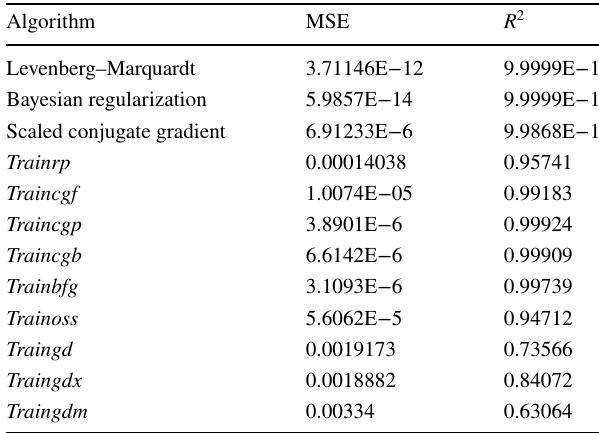
Table 2 Two-input variable ANFIS (exhaustive search) for chromium (VI) removal